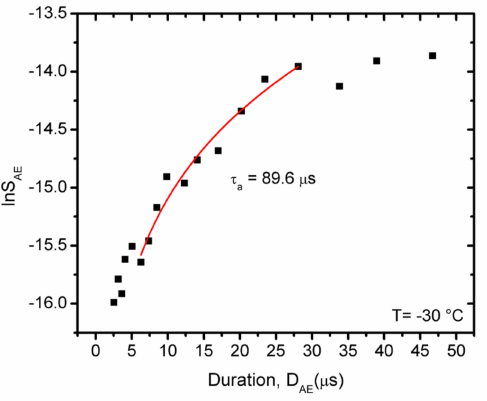
Figure 8. ln S AE versus D AE plot from points belonging to small values of D AE , which do not fit to τ a the S ∼ D γ relation in Figure 7a. From the fit (see Equation (5)) τ a = 90 µ s was obtained.